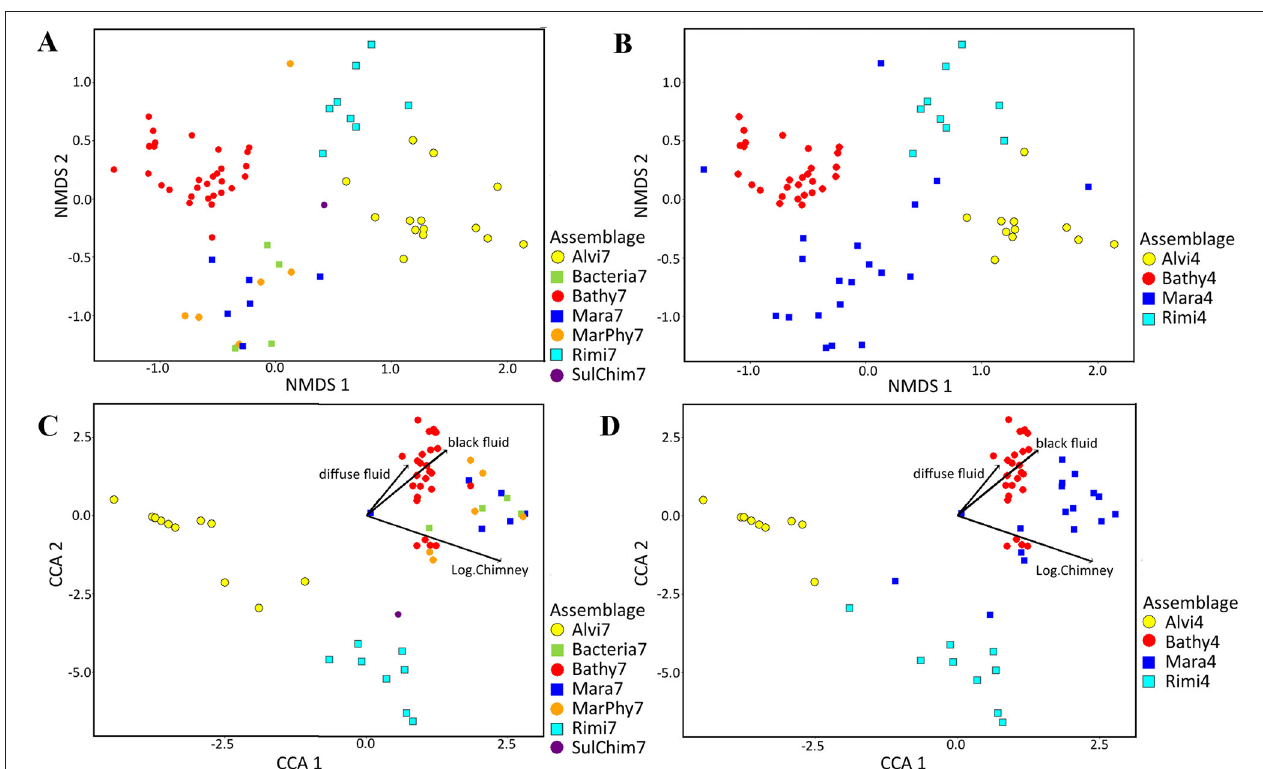
FIGURE 6 | NMDS plots of abundance and species based assemblage structure and CCA plots showing species and abundance distributions in relation to significant terrain variables. Abundance data was square root transformed and Bray Curtis dissimilarity was calculated for all figures. In total, 13 terrain variables were tested for their influence for the assemblage separation of which three variables were a priori log transformed (chimney area, sulfide block area and assemblage area). (A) Taxonomic based nMDS plot with seven faunal assemblages (Stress = 0.12512). (B) nMDS plot with four faunal assemblages (Stress = 0.12512). (C) Canonical correspondence analysis (CCA) using the Bray Curtis dissimilarity matrix for combination of abundance based faunal assemblage separation and its relation to terrain variables for seven faunal assemblages. (D) CCA analysis with four